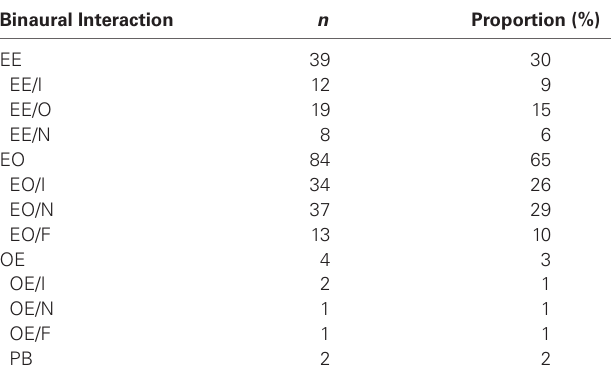
Table 1 | Proportions of auditory cortical neurons showing different binaural interaction types . Binaural Interaction